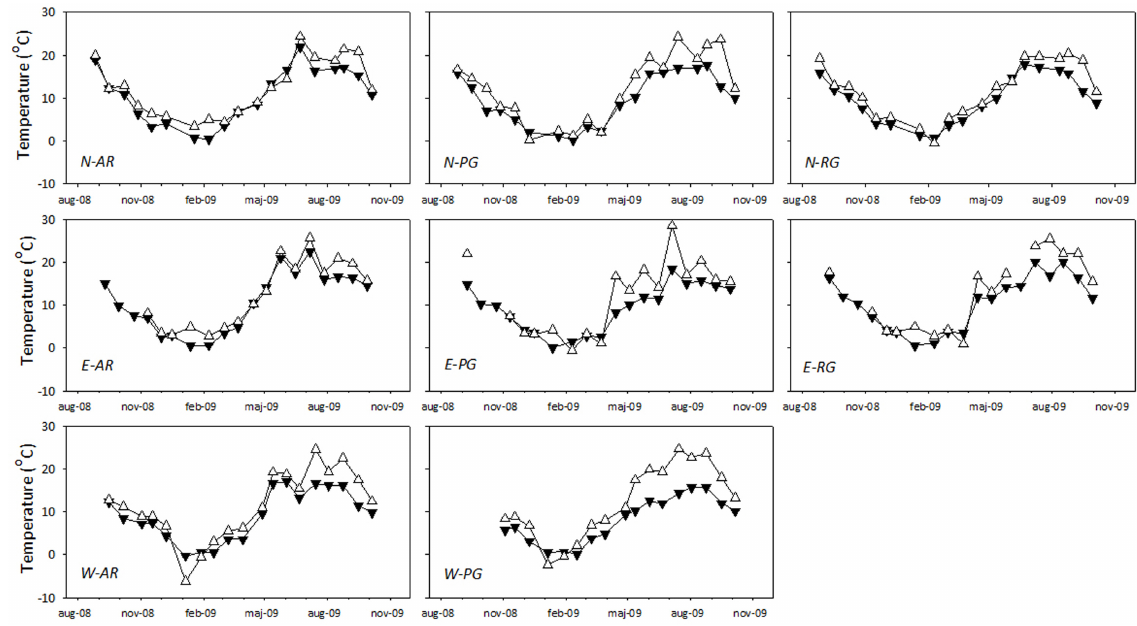
Fig. 2. Seasonal variations in soil temperature at 5cm depth ( H ) and air temperature at 200cm height ( M ) at the eight monitoring sites representing three regions ( W,N and E) and three land use categories (AR – arable crop; RG – rotational grass; and PG – permanent grass). The data shown were extracted from a database with continuous data to indicate conditions on sampling days. In region E some data were lost due to technical